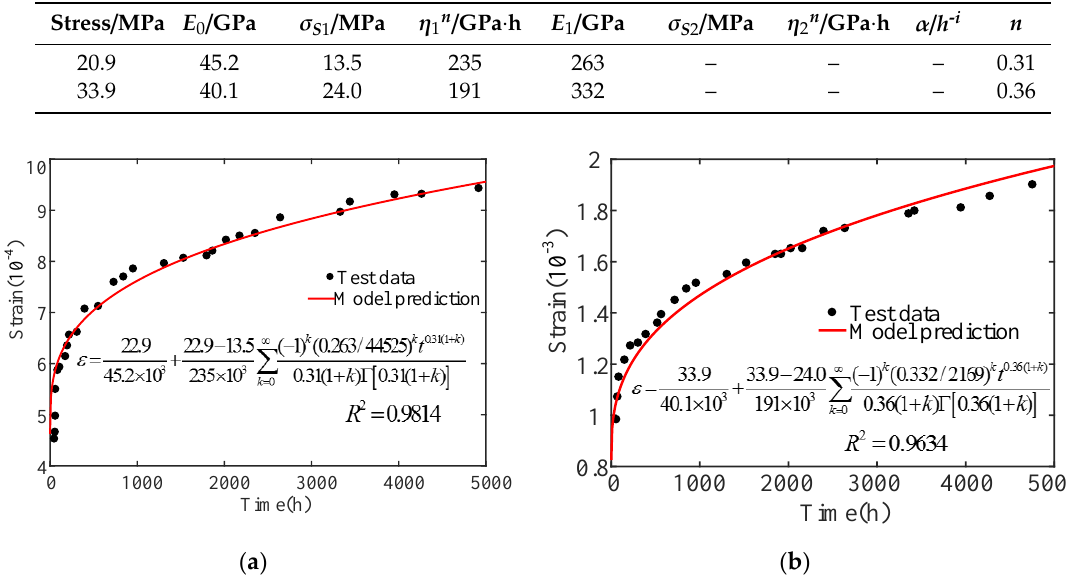
Figure 4. The fitting curve of the test curve and the model at (a) 20.9 MPa and (b) 33.9 MPa).